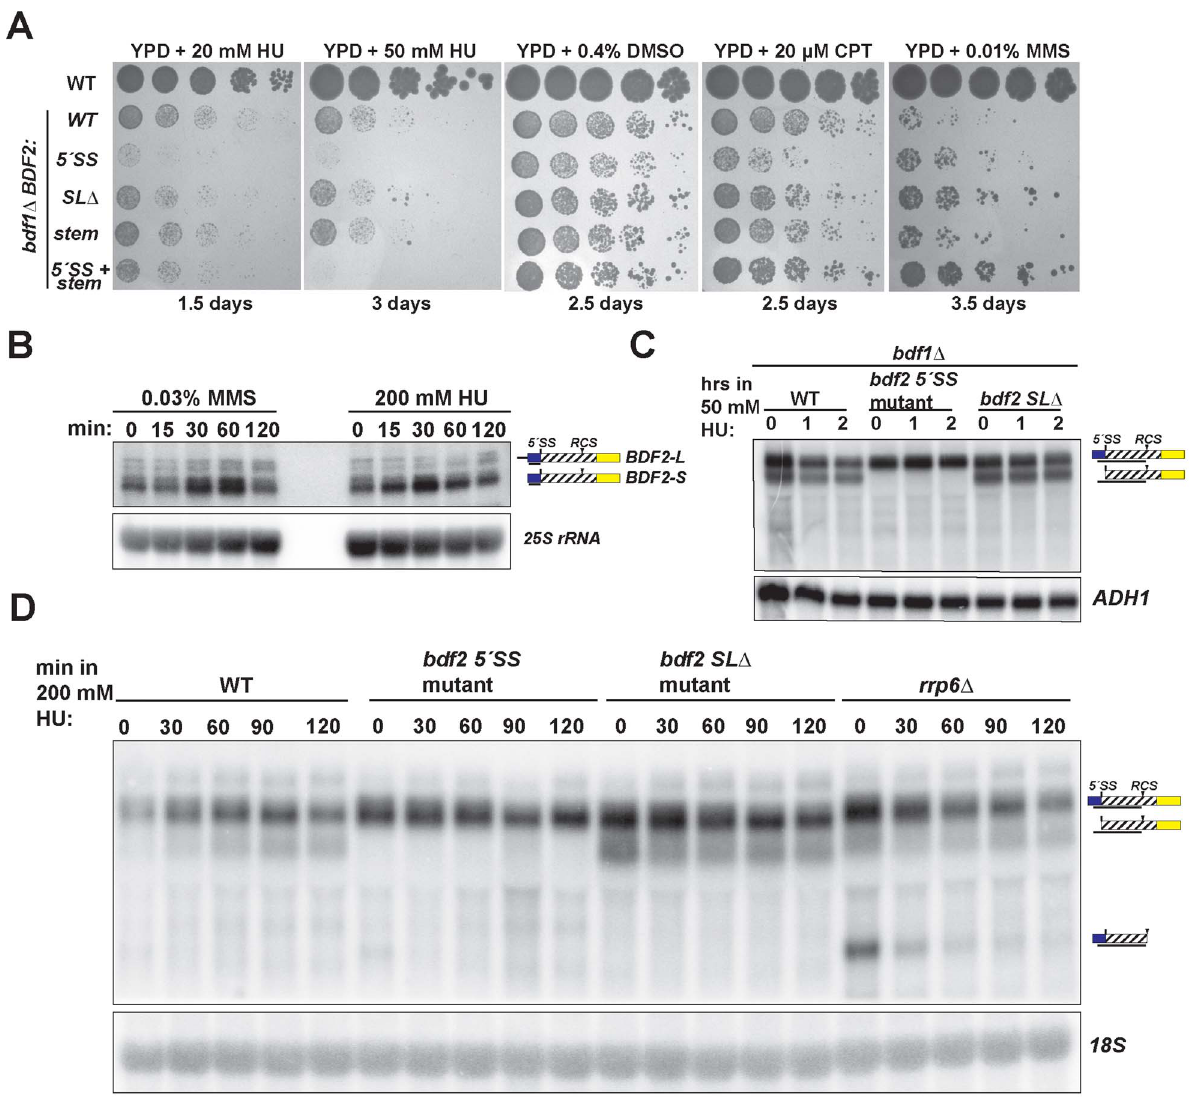
Figure 4. Spliceosome-mediated decay of BDF2 mRNA predominates over Rnt1p cleavage during DNA replication stress. A . The set of strains from Figure 2 were grown on media containing the indicated concentrations of hydroxyurea (HU), dimethyl sulfoxide (DMSO), which was the vehicle control for camptothecin (CPT), and methyl methanesulfonate (MMS). B . The wild-type strain was incubated with the indicated concentrations of MMS or HU for the indicated time points. BDF2 mRNA was detected with a riboprobe targeting exon1. The 25S rRNA is a loading control. C . bdf1 D strains carrying either WT BDF2 , the 5 9 -SS mutation ( 5 9 -SS mut ), or the deletion of the Rnt1p target stem loop ( bdf2 SL D ), were exposed to 50 mM HU for 1 and 2 hours. The BDF2 full-length mRNA and SMD intron-exon2 degradation intermediates were detected with an exon1- intron riboprobe. ADH1 is a loading control. D . The indicated strains were exposed to 200 mM HU for the specified time points. BDF2 mRNA and the SMD and RMD degradation intermediates were detected with same probe as (C). The 18S rRNA was probed with a radiolabeled oligonucleotide as a loading control.